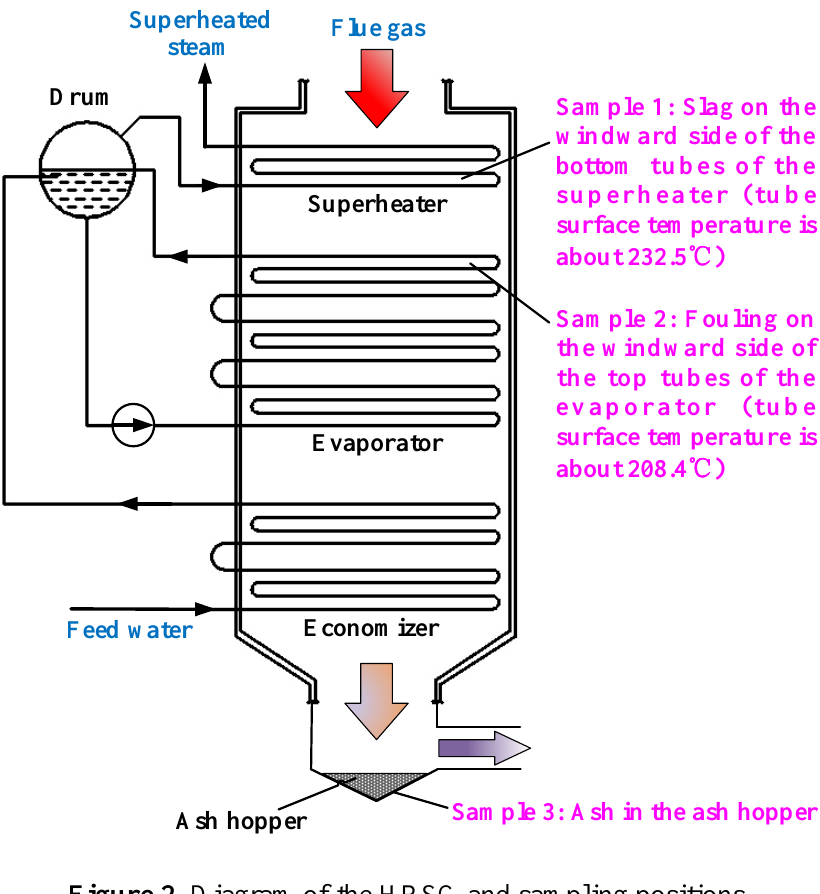
Figure 2. Diagram of the HRSG and sampling positions. Table 1. Operating parameters of the HRSG.